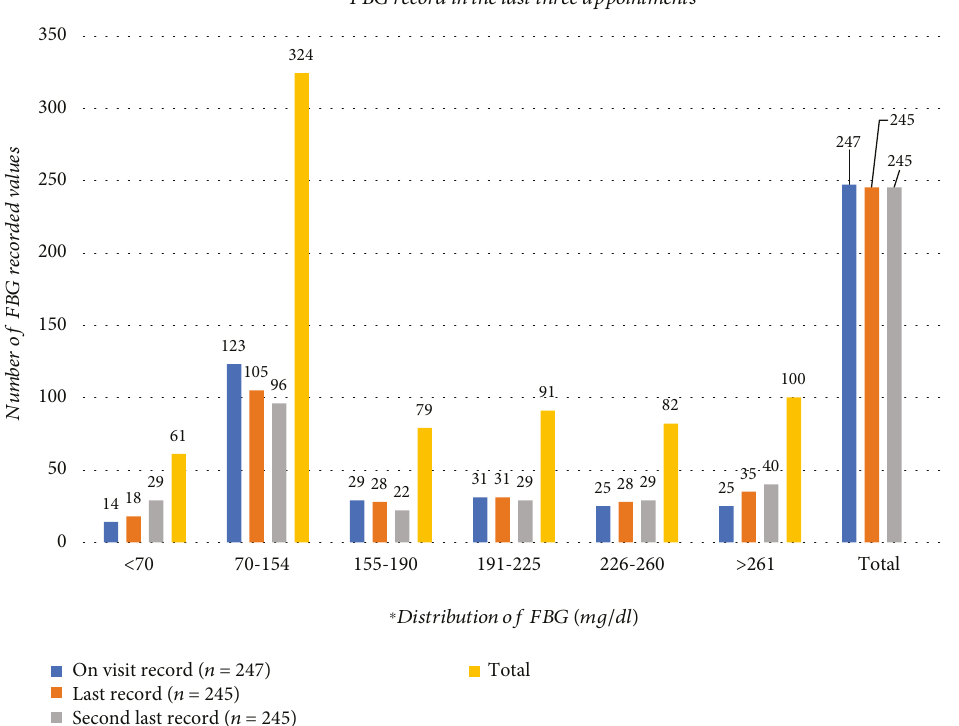
Figure 2: Three consecutive follow-up measurements of FBG level among ambulatory T1DM patients attending the diabetes clinics of SPHMMC from June 01 to August 01, 2018. ∗ The FBG level of distribution category is based on DCCT, expressed as hypoglycemia: < 70 mg/dl, normal: 70-154 mg/dl, excellent: 155-190mg/dl, good: 191-225 mg/dl, fair: 226-260 mg/dl, and poor: > 261